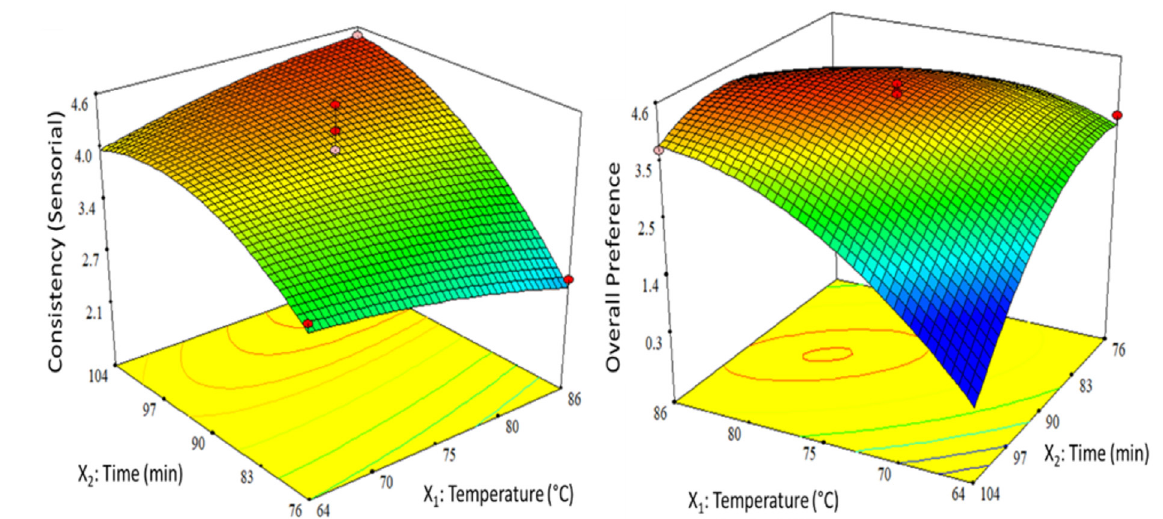
Figure 3. Calculated effects of process variables; cooking temperature and cooking time on consistency (sensorial) and overall preference of vacuum evaporated tomato